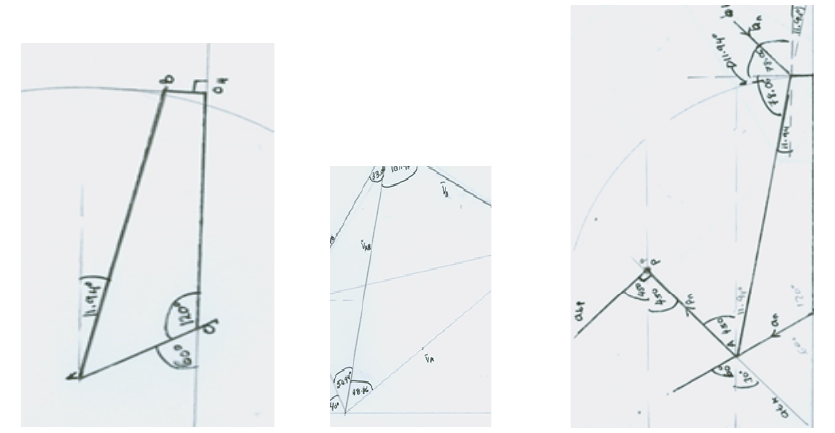
Fig. 2. Example of hand drawn kinematic analysis